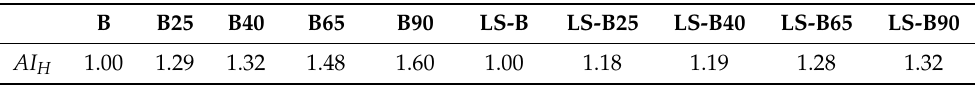
Table 7. Aging indexes from the relaxation spectra.